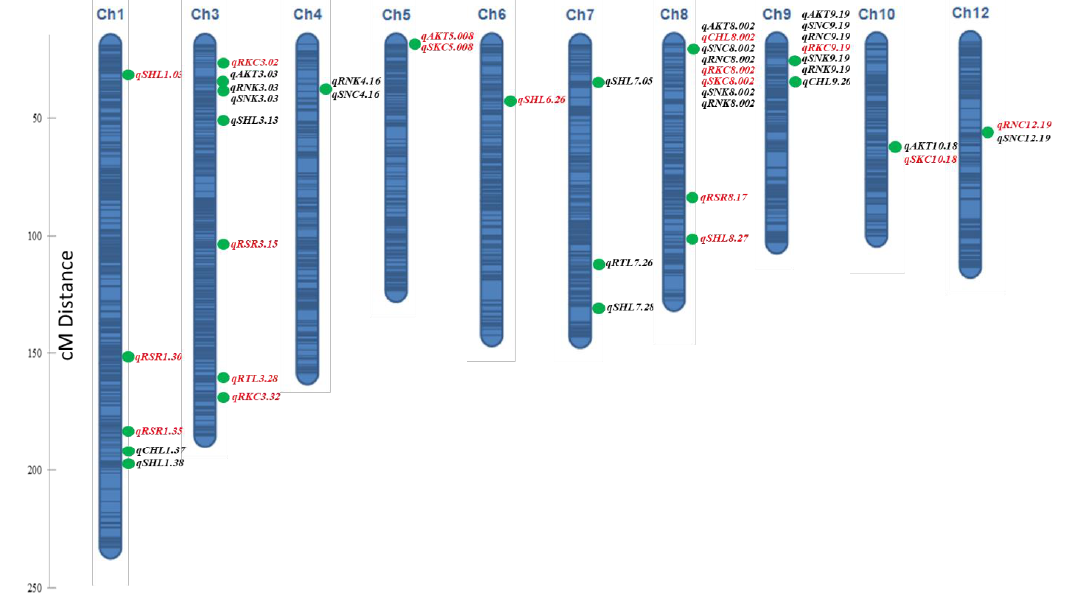
Figure 4. Map positions of the QTLs for eleven morphological and physiological traits in the Cocodrie × N22 RIL population. N22 and Cocodrie alleles responsible for the increased mean are indicated in black and red font, respectively. Dark regions on the genetic map are the marker-saturated regions; light regions represent gaps between the markers.